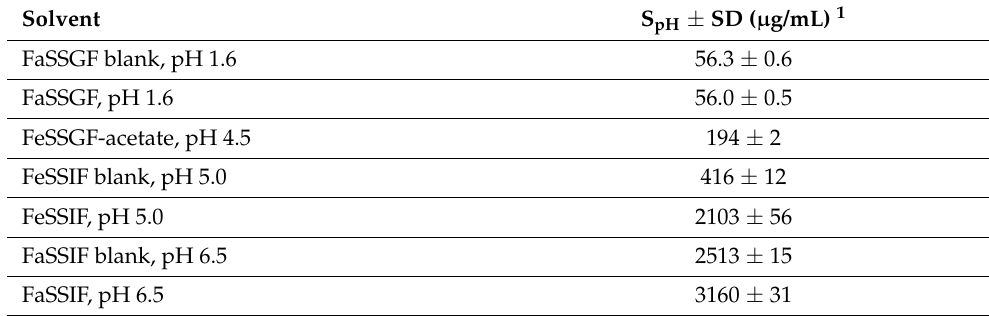
Table 4. Equilibrium solubility of ibuprofen in biorelevant media at 37 °C.